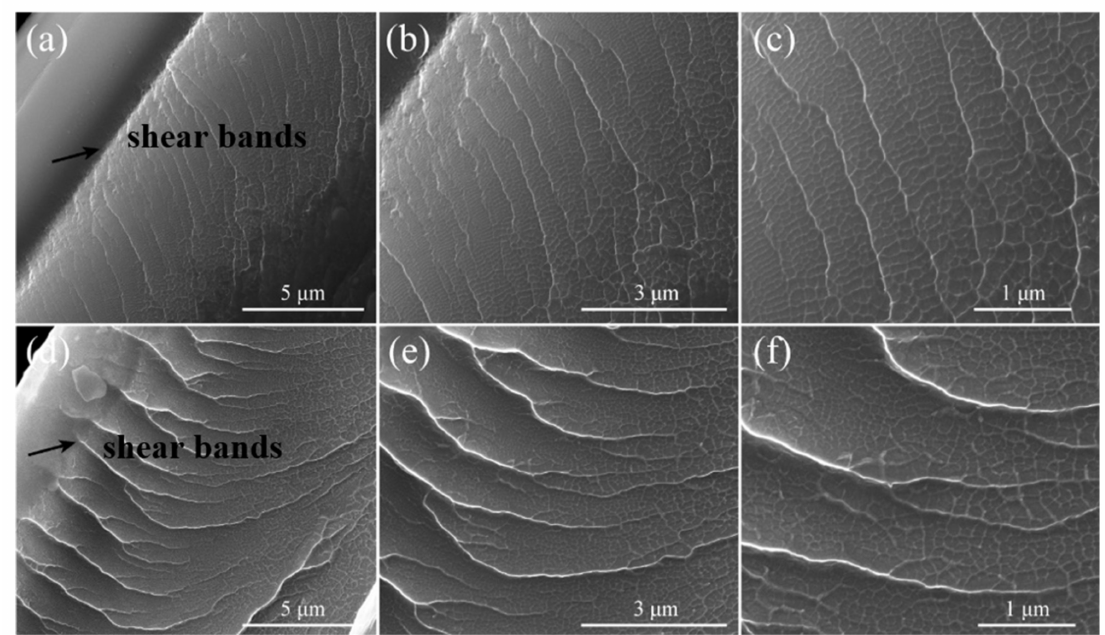
Figure 6. SEM images showing bending fracture of the magnesium-based amorphous alloy ribbon